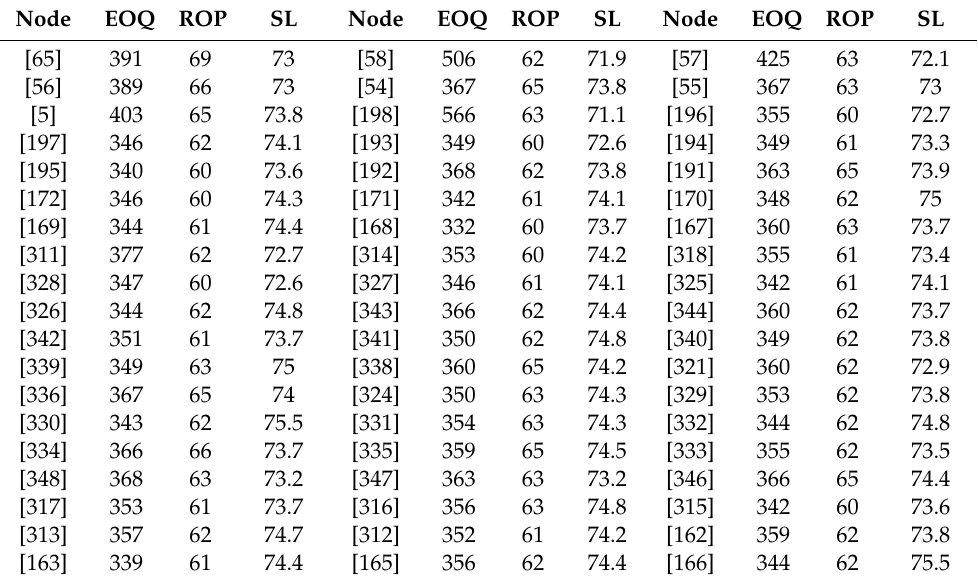
Table 10. The economic order quantities (EOQ), optimal reorder points (ROP), and optimal service levels (SL) of all retail stores located in Route 1 based on POPIRPSDRCO 2